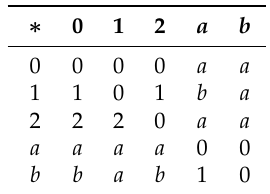
Table 3. Cayley table for the binary operation “ ∗ ”.